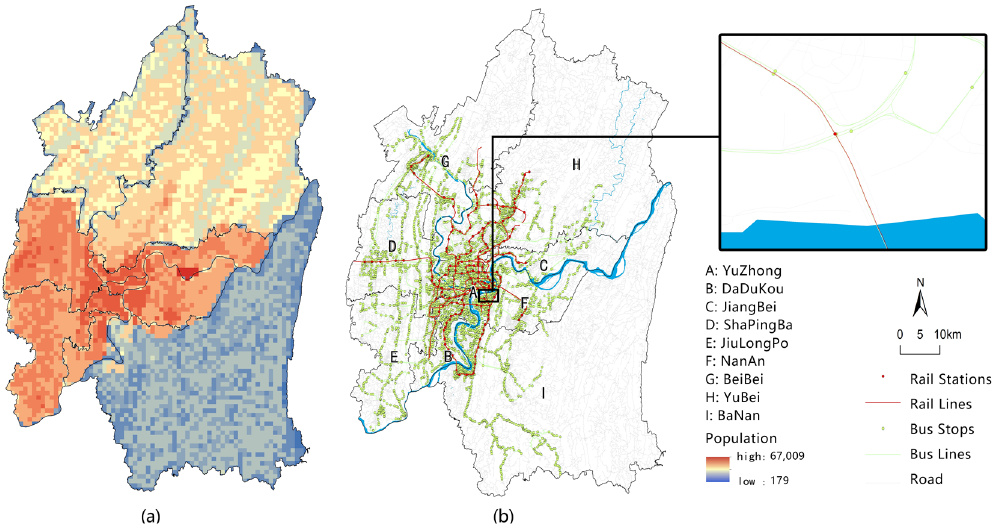
Figure 2. Population and traffic data of the main urban area: ( a ) population data of the main urban area of Chongqing; ( b ) public transport road network data in the main urban area of Chongqing.